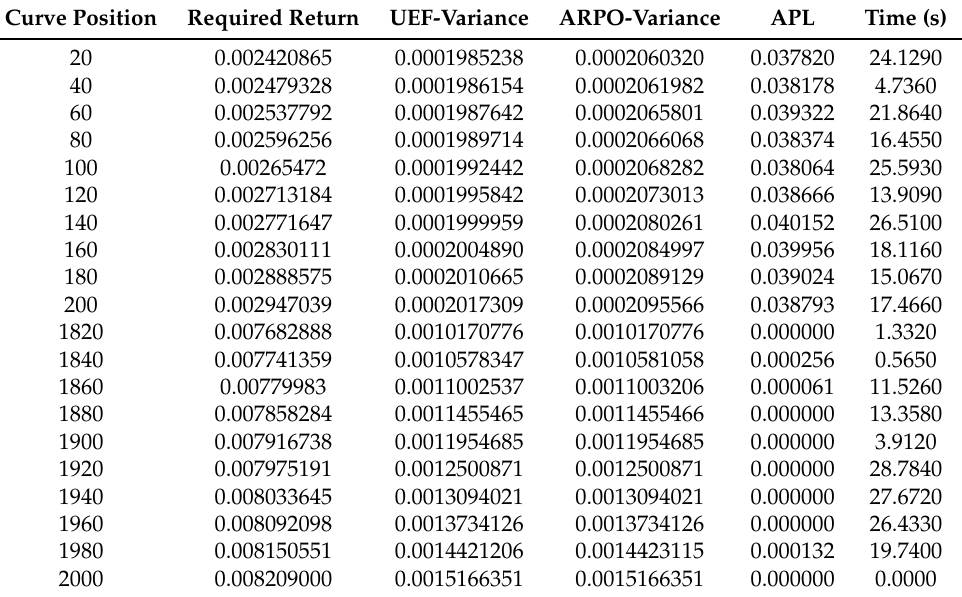
Table 4. FTSE 100 Stock Market (United